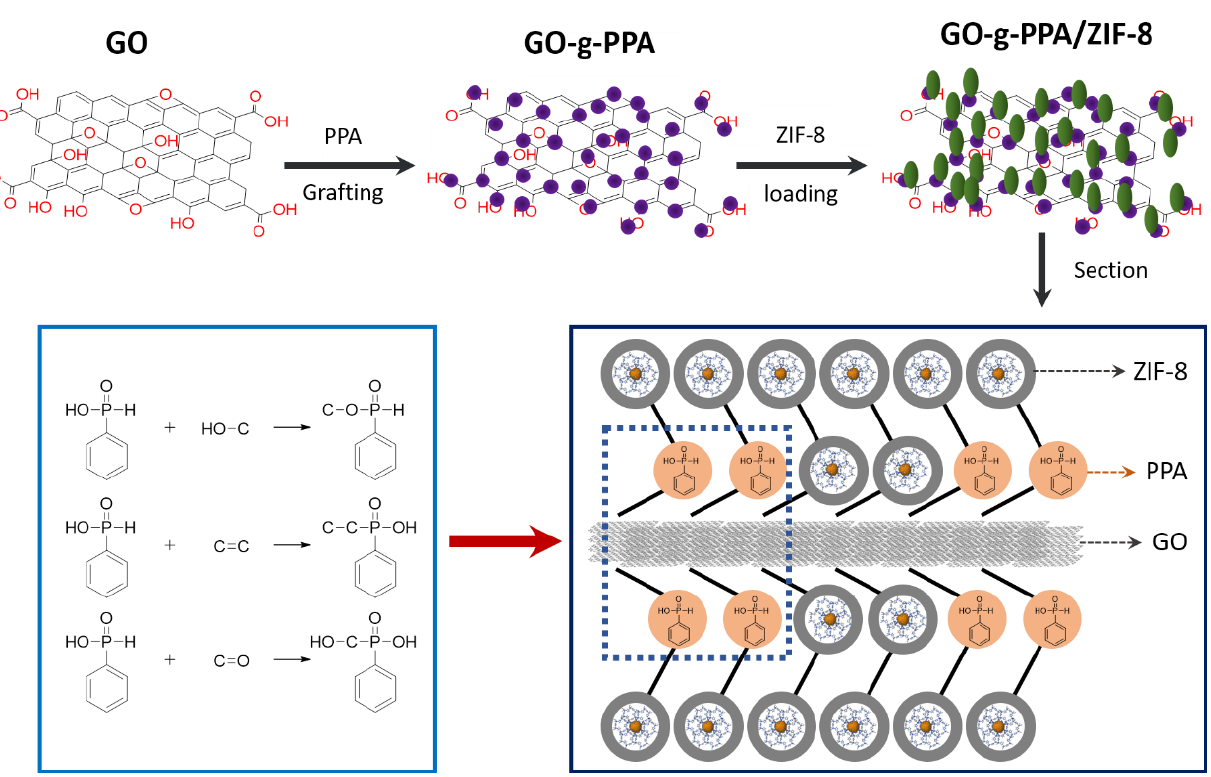
Figure 29. Synthesis of GPZ. Reproduced with permission from Ref. [199]. Copyright 2020, Elsevier.